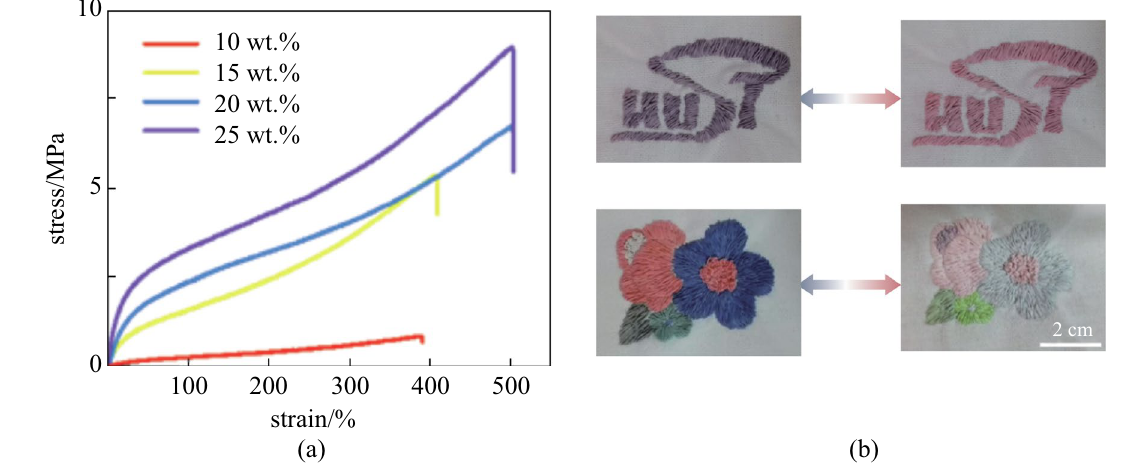
Fig. 2 Performance of thermochromic fibers. a Stress/strain curves of thermochromic fibers at increasing TPU content, TPU percentage is increased from 10 wt.%, 15 wt.%, and 20 wt.% to 25 wt.%. b Display fabrics with different patterns (“HUST” and a flower) and their colors at 31 °C and 55 °C (scale bar: 2